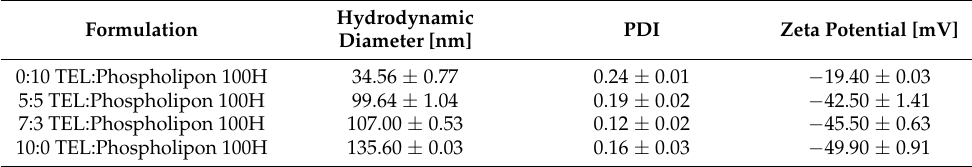
Table 1. The mean hydrodynamic diameter, polydispersity index (PDI), zeta potential, and encap- sulation efficiency (EE) of liposomes composed of tetraether lipids (TEL) and Phospholipon 100H (Ph) in different molar ratios (0:10, 5:5, 7:3, 10:0; TEL:Ph). Formulation